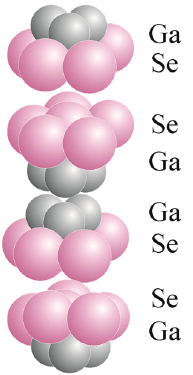
Figure 1. Schematic representation of the GaSe structure.